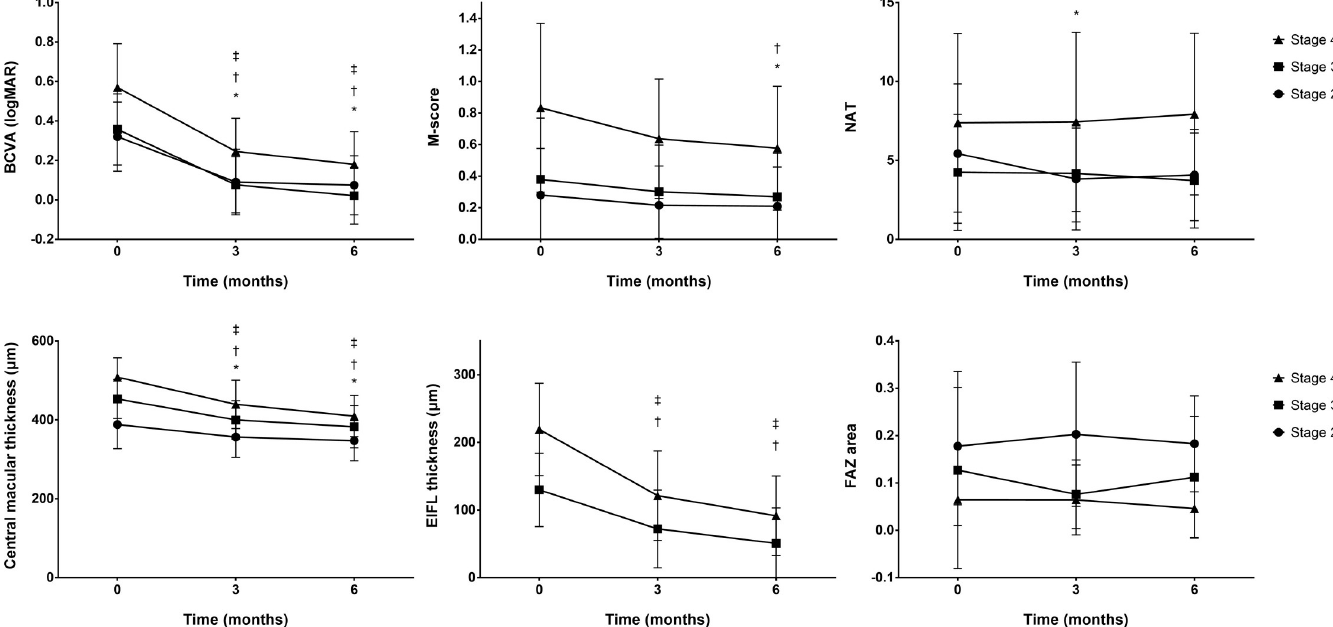
Fig 1. Postoperative changes in parameters according to the preoperative EIFL stage. Postoperative changes in best-corrected visual acuity (A), M-score (B), NAT score (C), central macular thickness (D), thickness of ectopic inner foveal layer (E), and area of foveal avascular zone (F). � , †, ‡ indicate significant changes from baseline in stage 2, 3, 4, respectively. BCVA, best-corrected visual acuity; M-score, M-chart score; NAT, New Aniseikonia Test score; EIFL, ectopic inner foveal layer; FAZ, foveal avascular zone.